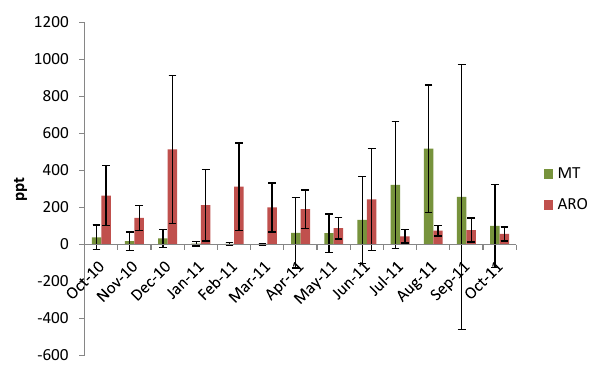
Fig. 1. Monthly mean mixing ratios and standard deviations of monoterpenes and aromatic hydrocarbons at Hyyti¨al¨a. Episodes are not included.